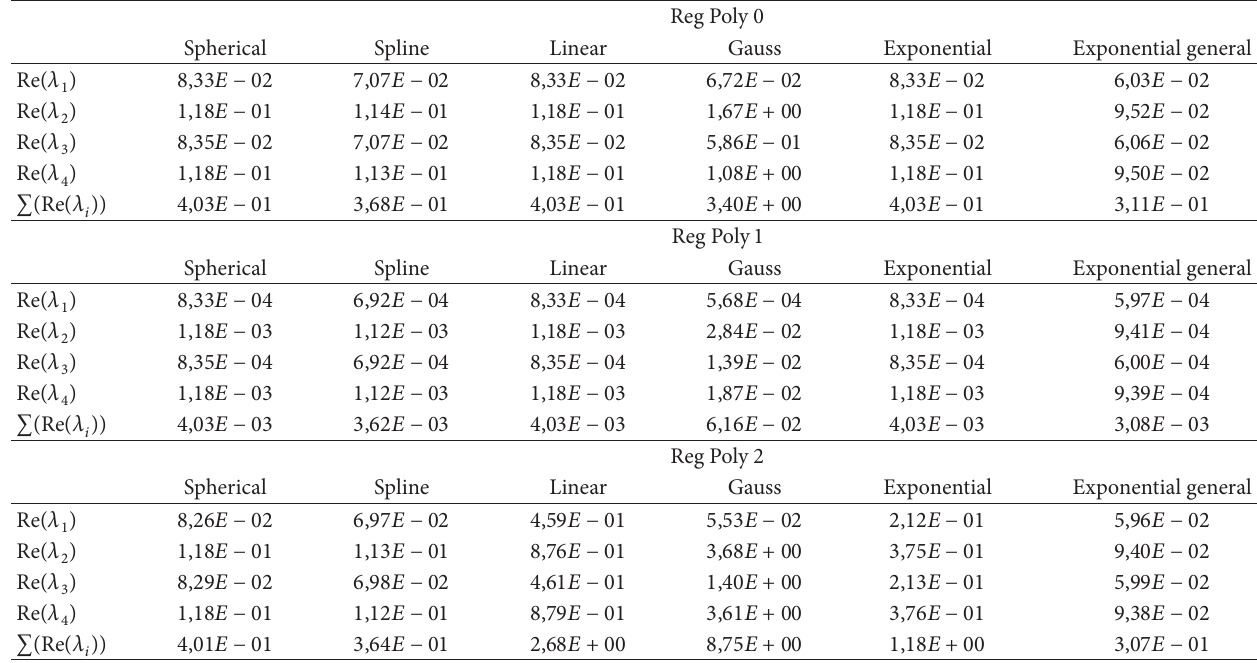
Table 3: Configuration 1: quadratic mean of absolute error on real parts of eigenvalues for different regression and correlation kriging functions.